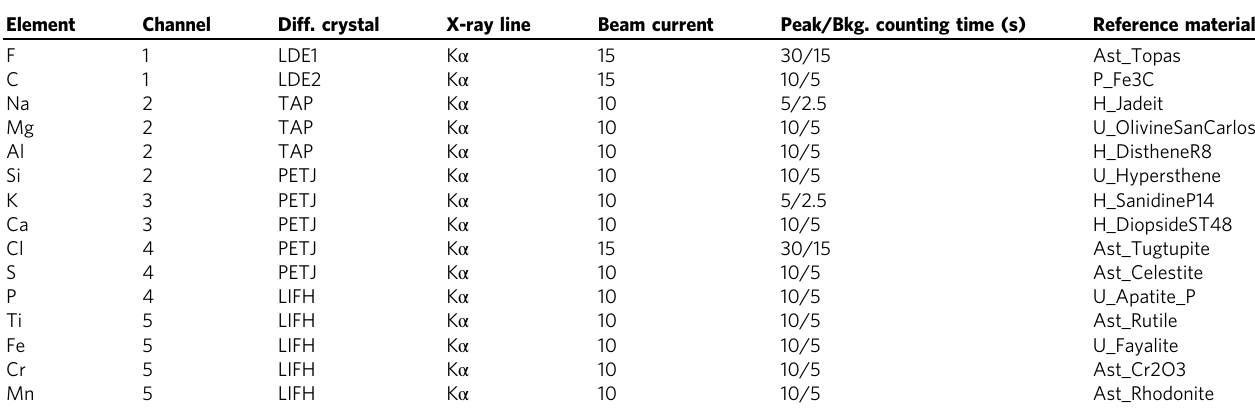
Table 2 Electron microprobe analytical conditions at 15 and 10 kV and 1 – 10 µ m spot size. Element Channel Diff. crystal